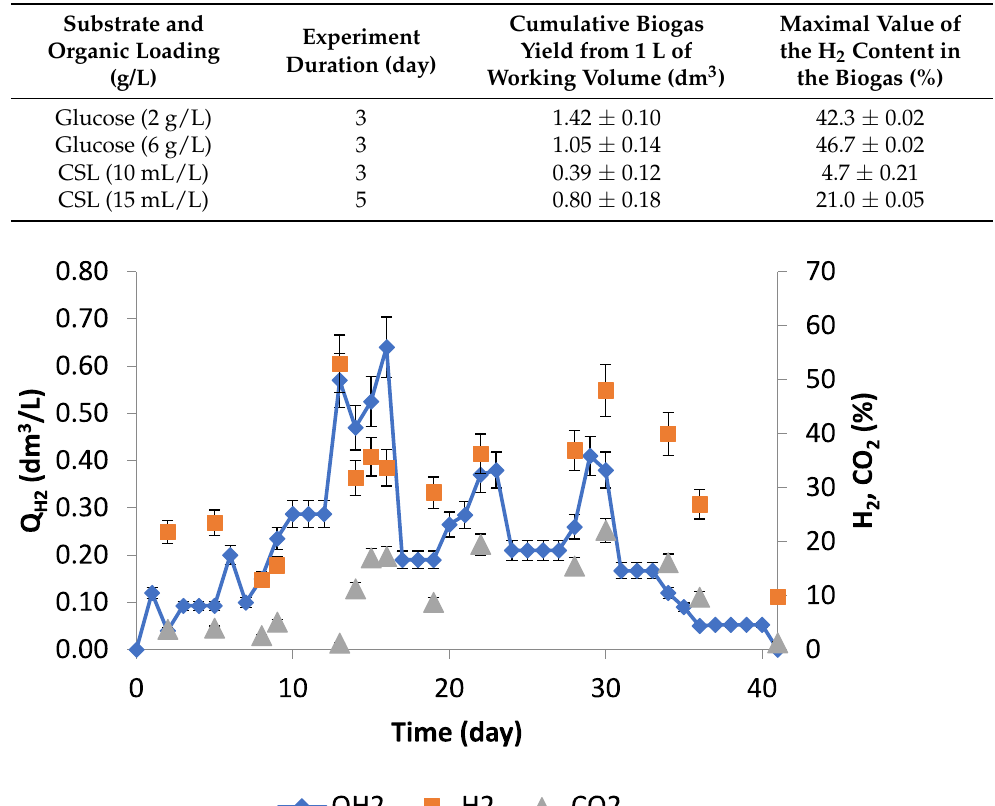
Table 2. Influence of the organic load and the process duration on the hydrogen content and the biogas yield.